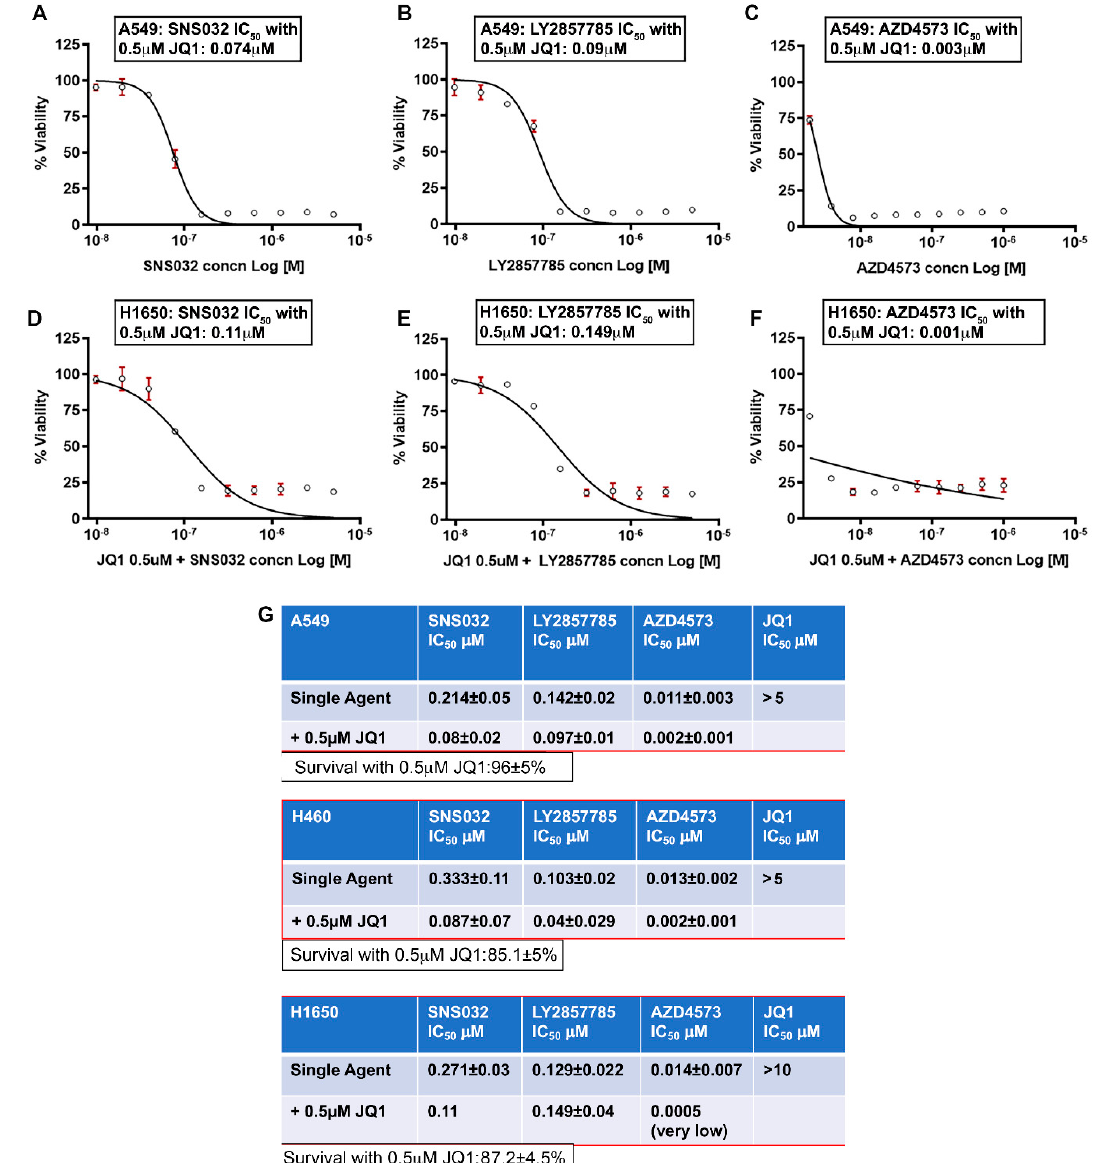
Figure 3. BRD4 inhibitor JQ1 enhances the sensitivity of CDK9 inhibitors on lung cancer cells: ( A – F ) representative IC 50 curves for CDK9 inhibitors with JQ1: A549 ( A – C ) and H1650 ( D – F ) cells were treated with 10 different concentrations of SNS032, LY2857785, or AZD4573, in the presence of 0.5 µM JQ1, for 96 h, and IC50 analysis was conducted using GraphPad Prism. ( G ) Chart shows the IC 50 values (mean ± SD) for SNS032, LY2857785, or AZD4573 alone or in combination with 0.5 µM JQ1 and for JQ1 alone, from three independent experiments conducted in duplicate. JQ1 by itself at 0.5 µM showed very little effect on the cancer cells; more than 85% of the cells were alive.